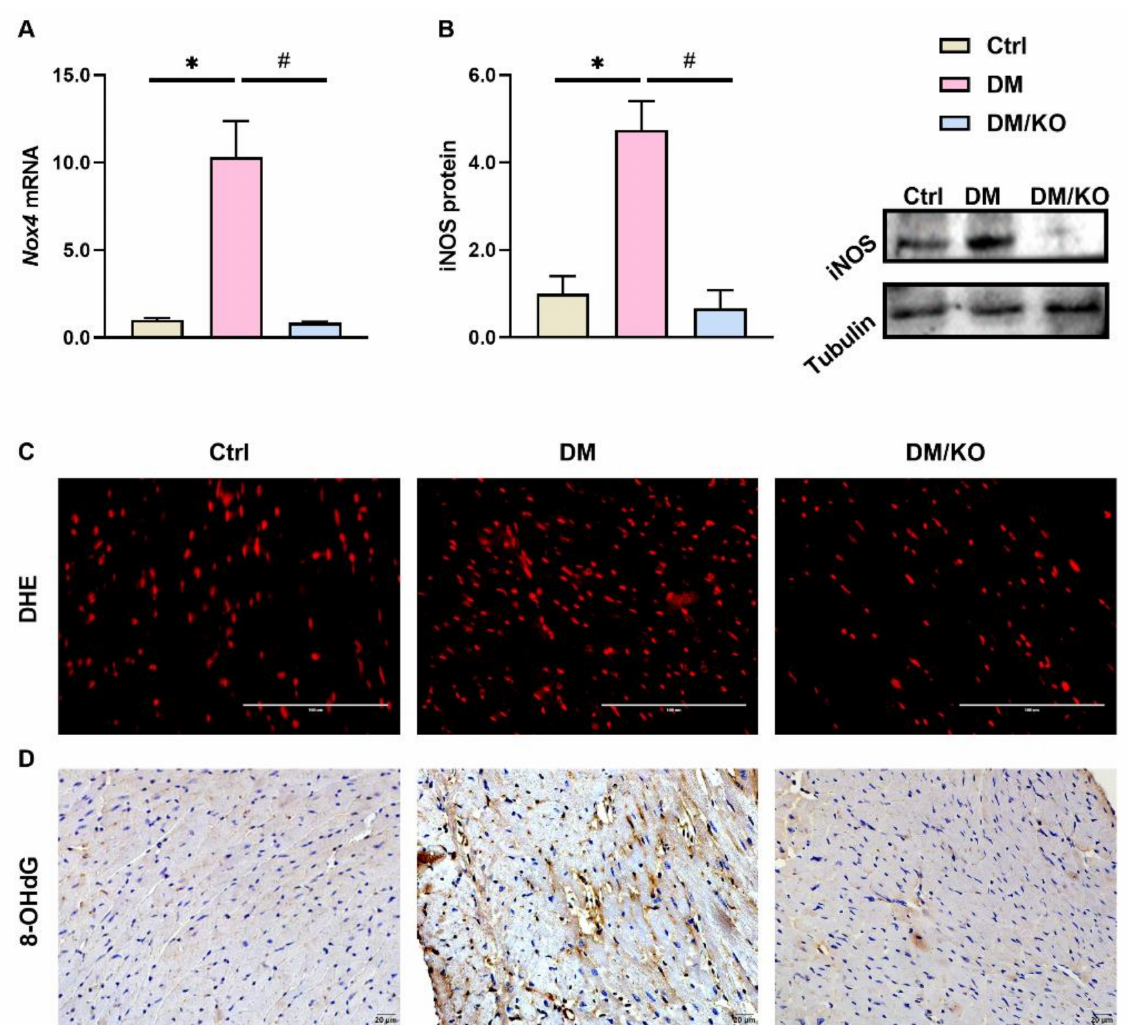
Figure 3. KO attenuated the DM-generated cardiac oxidative stress. ( A ) Nox4 mRNA levels. ( B ) iNOS protein levels. Tubulin and Rplp0 were used as endogenous controls for Western blot and qRT-PCR, respectively. ( C ) Representative microphotographs of DHE staining in heart sections in each group (Bar = 100 µ m). ( D ) Immunohistochemical staining showed expression of 8-OHdG (Bar = 20 µ m). The data were normalized to Ctrl and summarized as means ± SD. *, p < 0.05 vs. Ctrl; #, p <